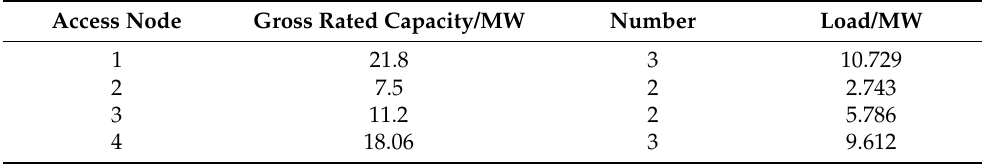
Table 1. Basic information of the diesel generator and load of the electric power system.